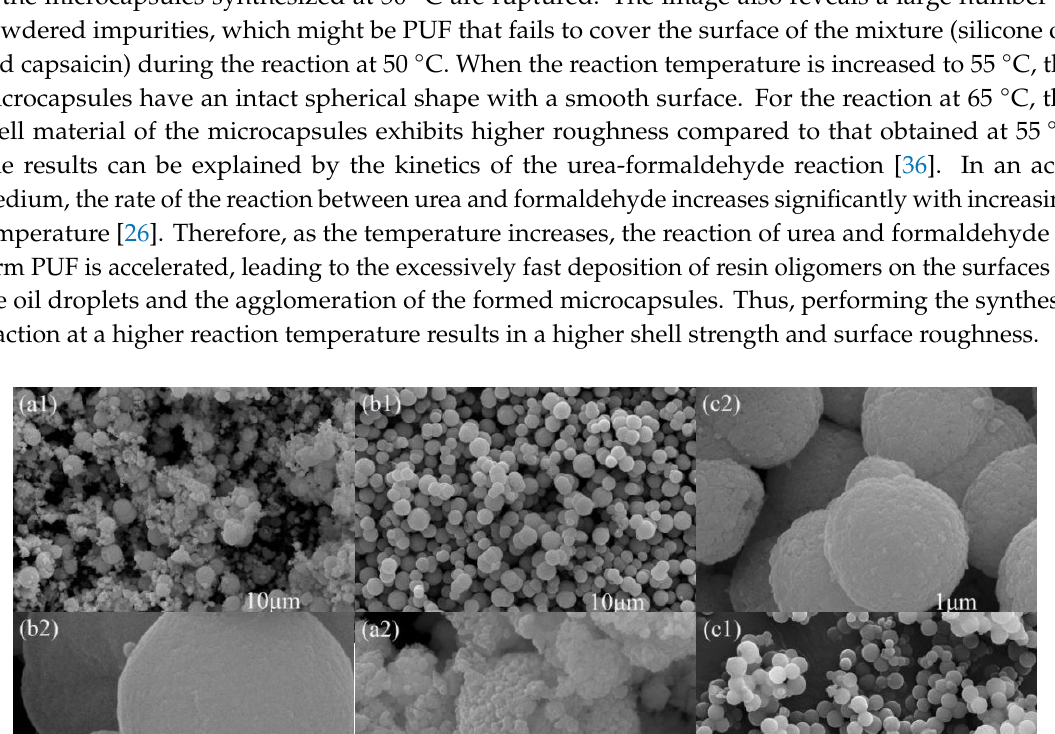
Figure 9. SEM images of the coatings ( a ) without microcapsules and with ( b ) 5%; ( c ) 10%; and ( d ) 15% microcapsules. 3.3.1. Contact Angles and Slow ‐ Release Effect of the Microcapsules Coating The data generated by the contact angle analyzer is reported in Figure 10. A closer look at the data indicates that the contact angles of the coatings are greater than 90° and that the surface energies are less than 30 mN/m, indicating that marine creatures should have difficulty attaching to them. The angle increases from ~91.99° for the pure resin coating to ~127.6° for the coating with 15 wt % microcapsules. The reduced surface energy is generally explained by the hydrophobicity due to the embedding of PUF microcapsules [36].